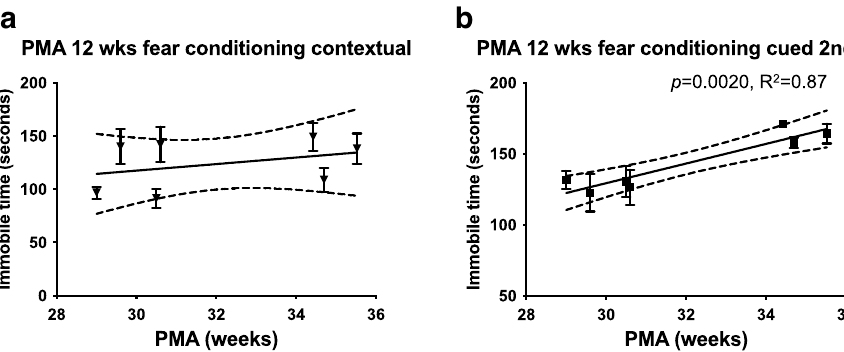
Figure 4. Increased PMA were positively correlated with fear learning and memory in the fear conditioning test. In the contextual memory test, the immobile time was not associated with increased PMA ( a ). In the cued fear retention test, the immobile time was significantly increased with increased PMA ( b ) in the second part of the cued fear conditioning test (different chamber and sound cue presented) by Pearson’s correlation coefficient analysis. The coefficient of determination (R 2 ) is also presented when significant correlation was reached at p < 0.05. Animal numbers used in each transfaunation groups were: gr_1 = 36, gr_2 = 8, gr_3 = 14, gr_4 = 6, gr_5 = 9, gr_6 = 11, and gr_7 =